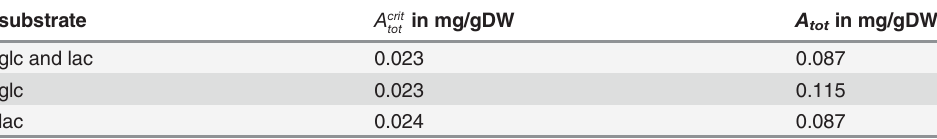
Minimal total molecular mass of amino acids A tot required to produce the metabolic output within 8h at different modes of substrate supply. A crit represents the minimal total molecular mass of amino acids required for only accomplishing the maintenance reactions. All genes were set to be active in these